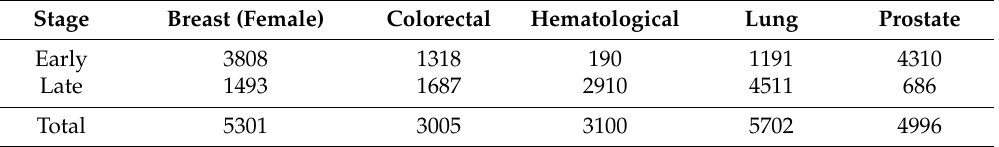
Table 2. Summary of cancer cases by stage and by primary site for